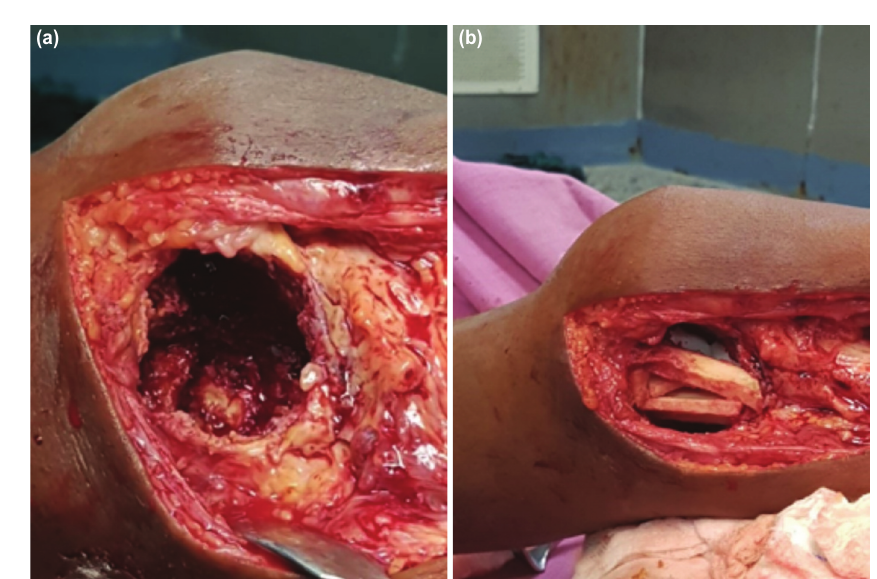
(a) Cavity after curettage (b) Cavity supported with fibula cortical Fig. 1: